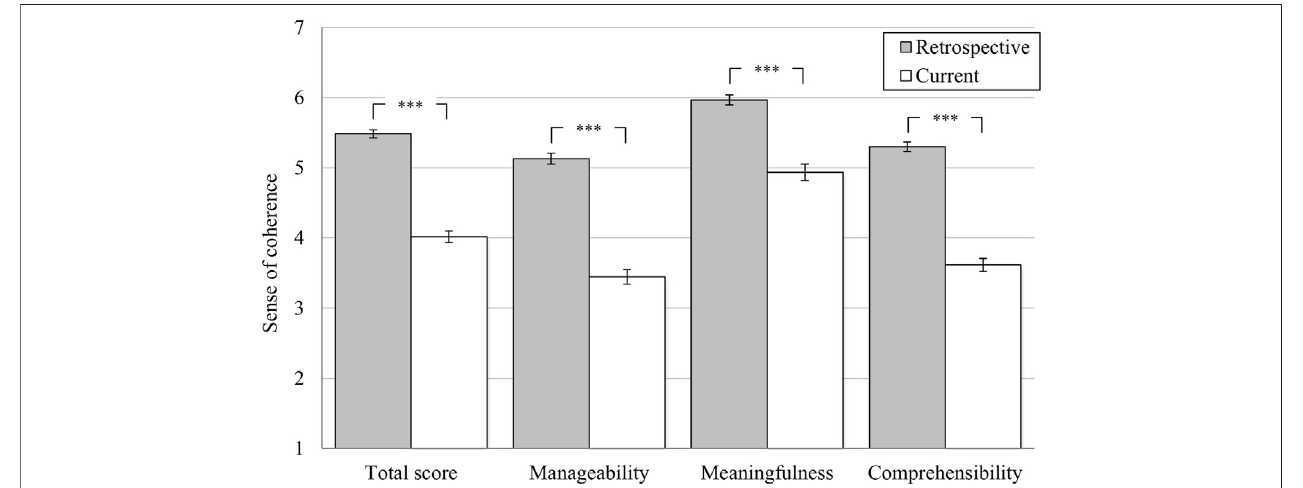
FIGURE2| Changein senseofcoherence including subscales. Notes: * p < 0.05; ** p < 0.01; *** p < 0.001; meanswith95%con fi dence intervals (7-point semantic differentials; see Table 1 for item anchors); retrospective (cid:1) retrospective rating related to a pre-pandemic time-point; current (cid:1) assessment at the current time-point (February/March 2021). N (cid:1) 648.